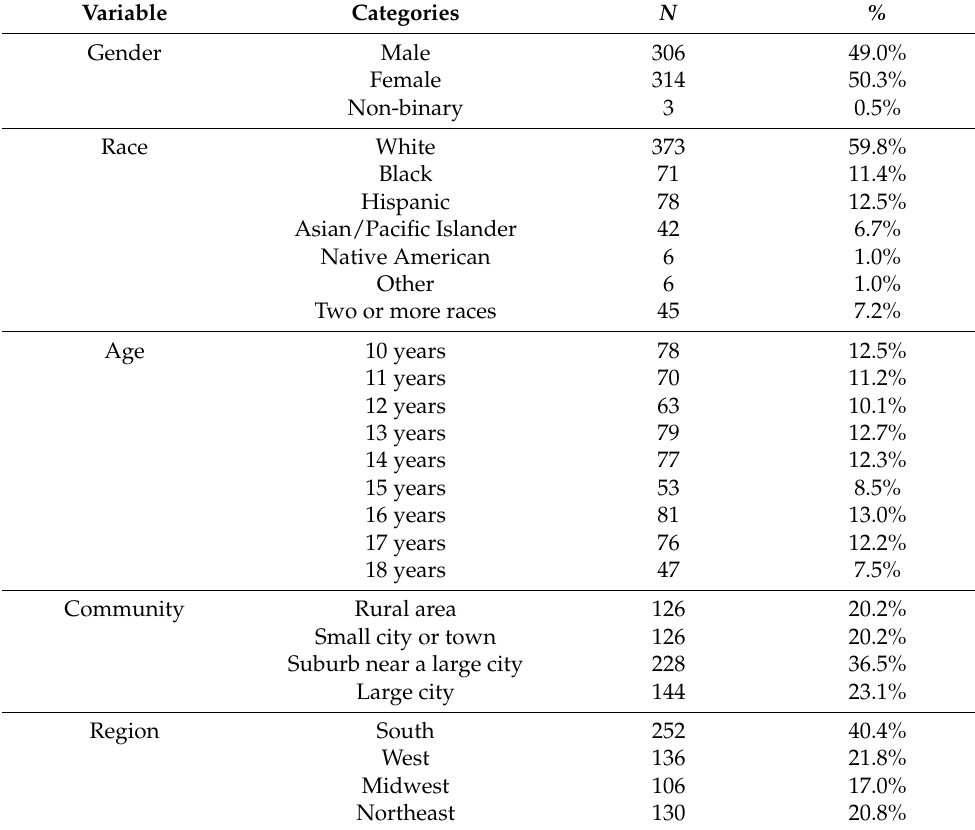
Table 3. Sample demographics ( N =